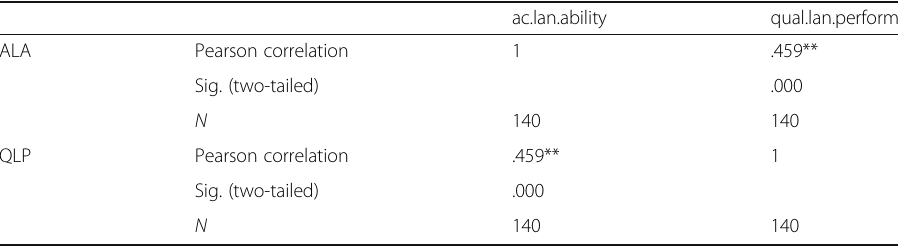
ac.lan.ability qual.lan.perform